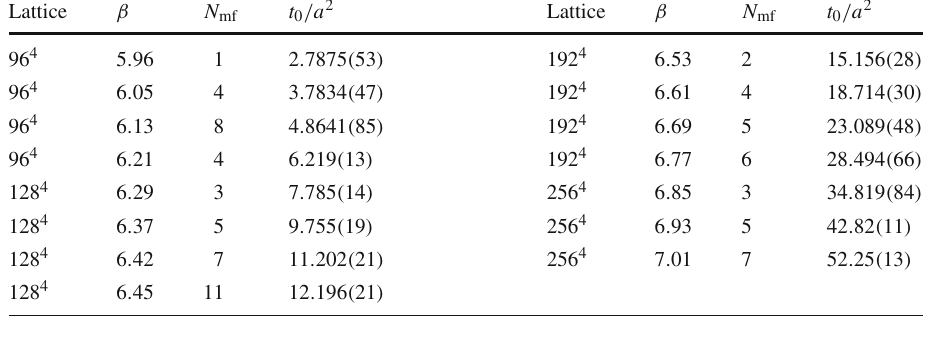
Fig. 1 Plot of the simulation results for ln ( t 0 / a 2 ) (diamonds) and the interpolation (2.5),(2.6). As shown by the plot on the right, setting the scale with t 0 or the available data for the Sommer radius r 0 [29,30] comes to the same within a margin of about 1% (grey band;